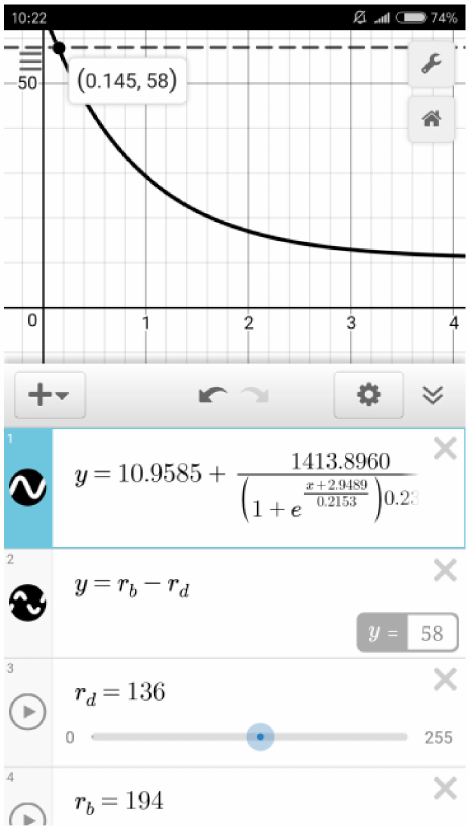
Figure 4. The established mode for malathion quantitation in Desmos on the